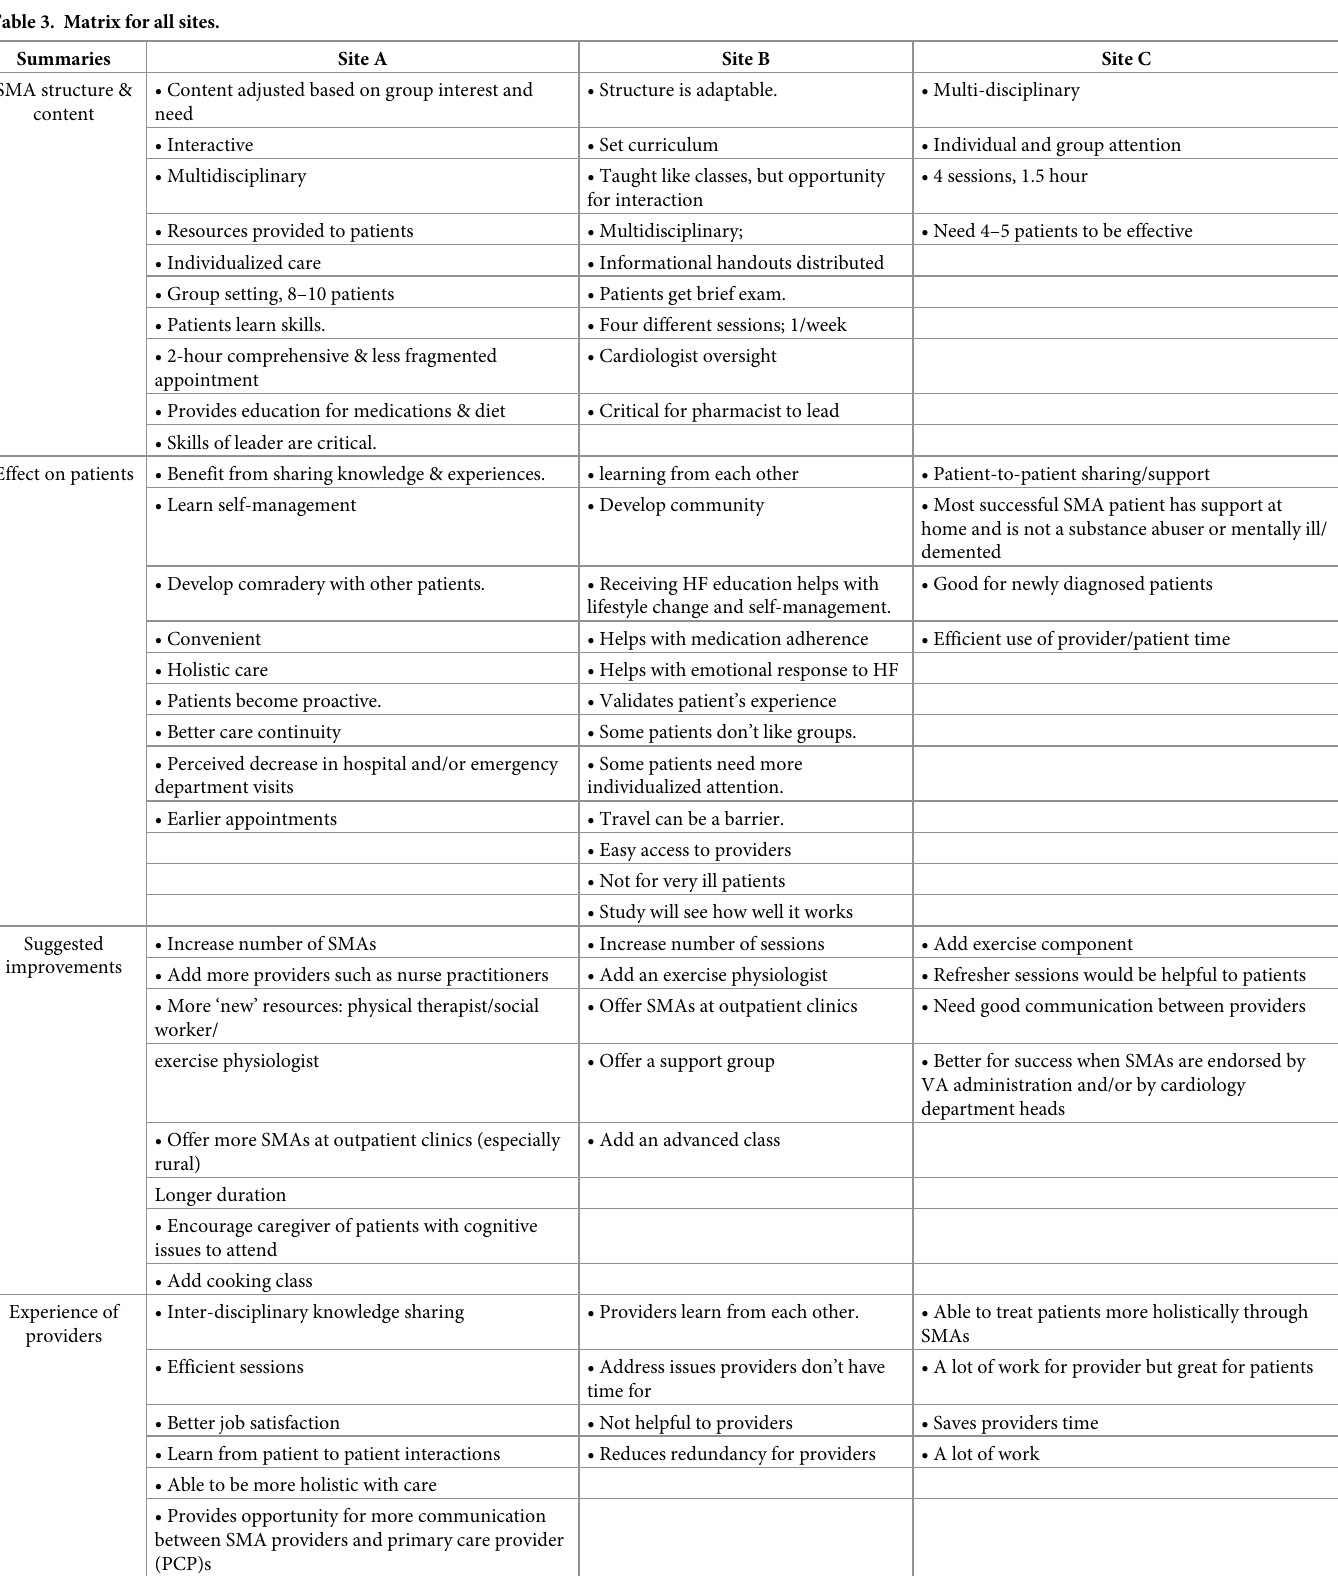
Table 3. Matrix for all